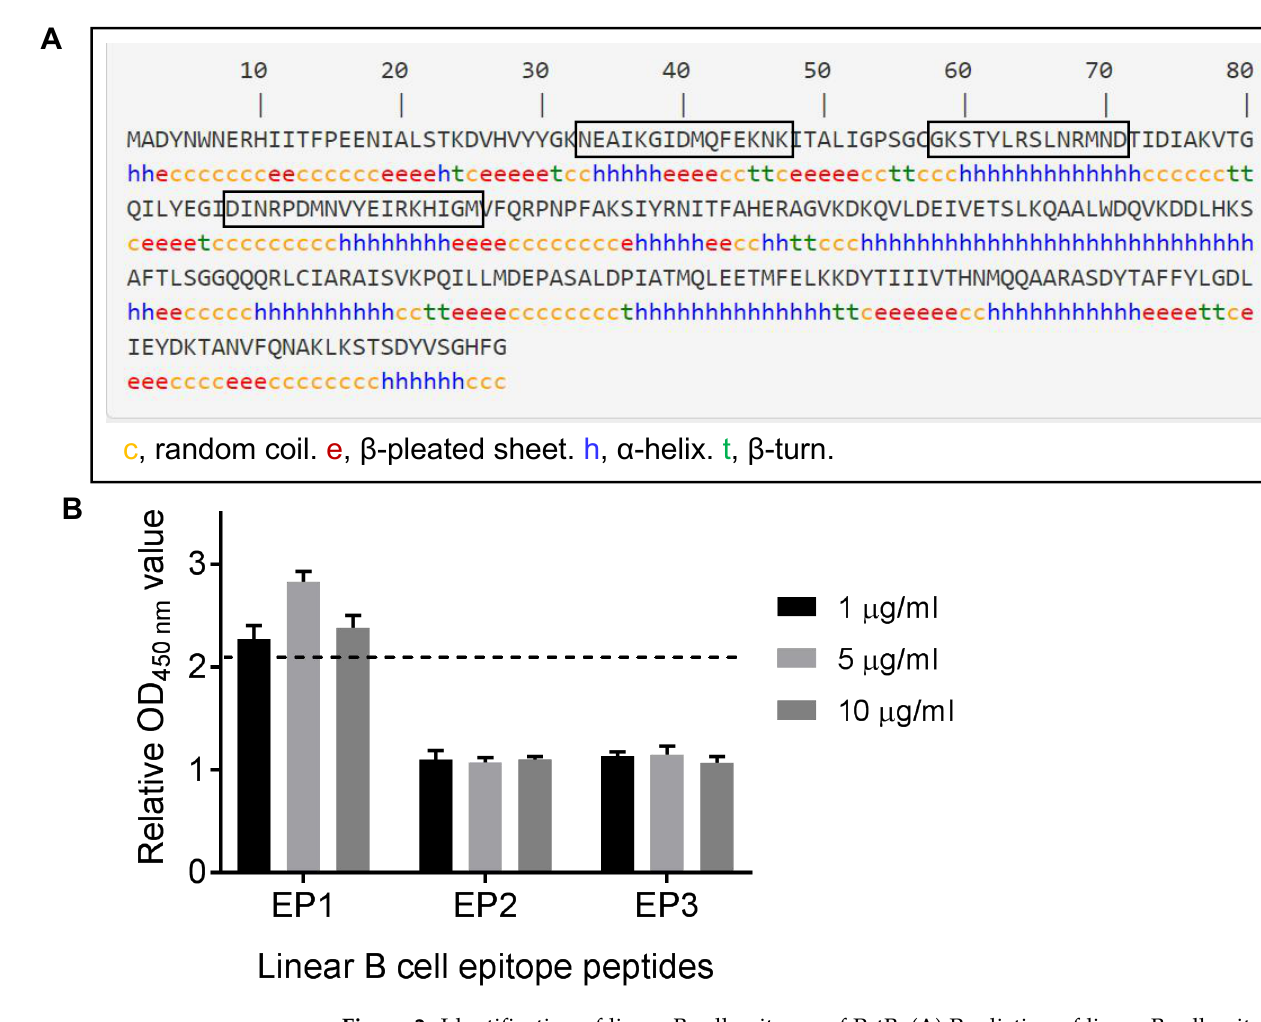
Figure 2. Identification of linear B cell epitopes of PstB. ( A ) Prediction of linear B cell epitopes of PstB using ABCpred and IEDB. The epitope sequences identified by both software tools are boxed. ( B ) Confirmation of linear B cell epitope peptides (EP) with ELISA immunoassay. The OD 450 nm value of each peptide was normalized to the control value and plotted. The relative OD 450 nm value of >2.1 was considered positive. Table 1. Predicted linear B cell epitopes of